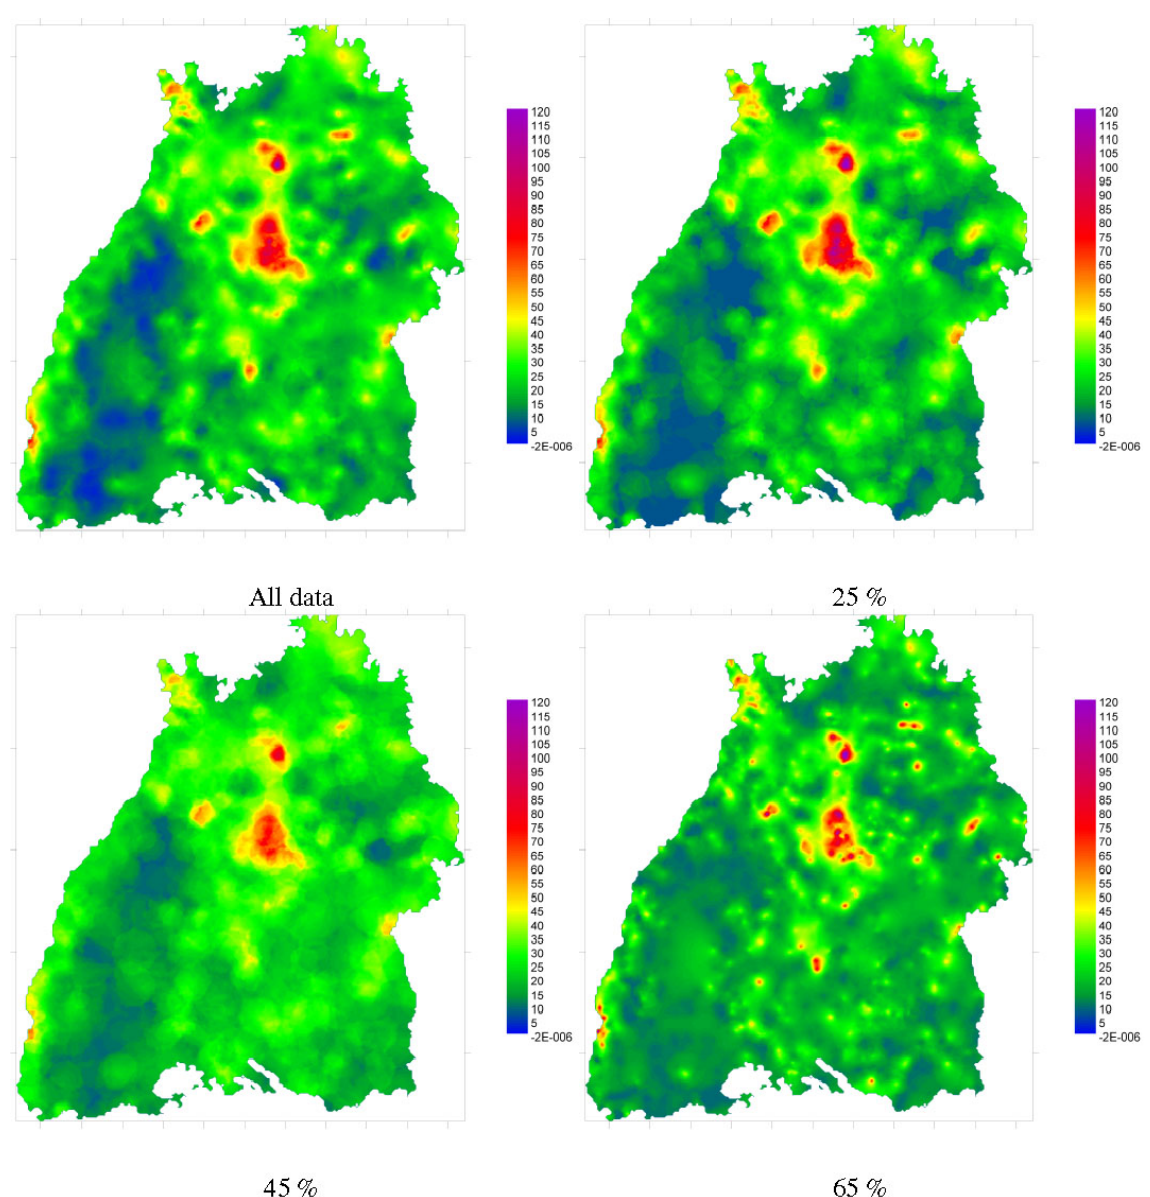
Fig. 4. Interpolated chloride concentrations for different grades of